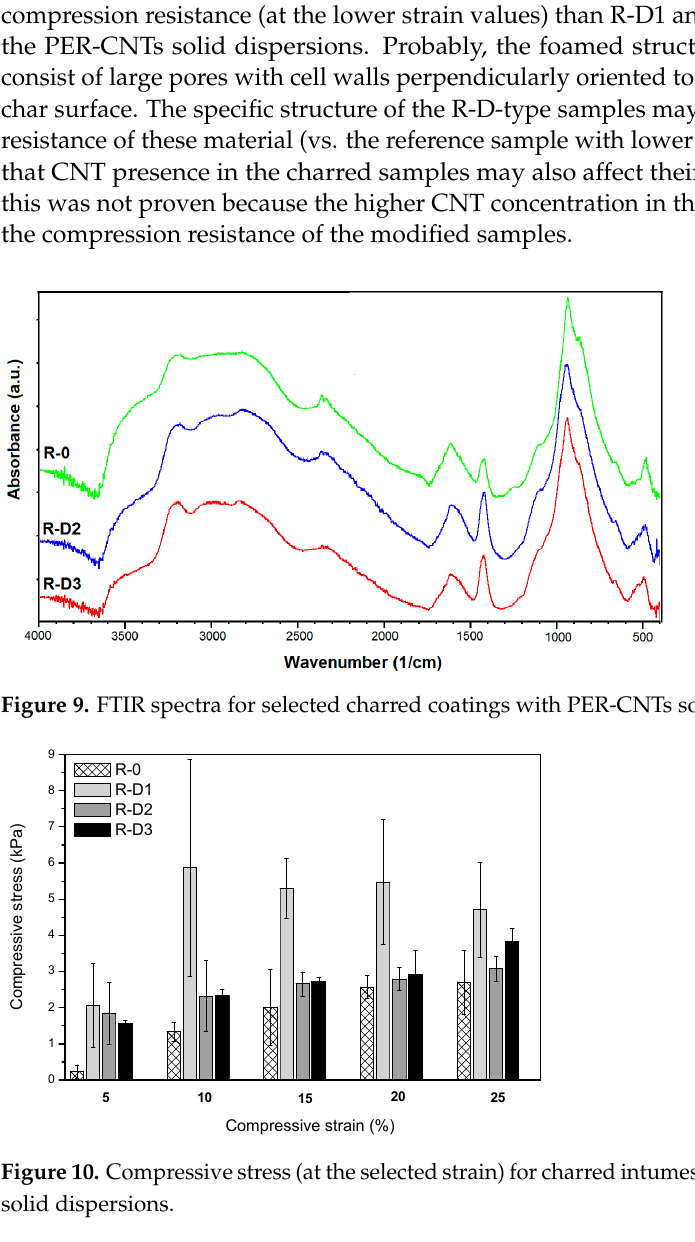
Figure 9. FTIR spectra for selected charred coatings with PER-CNTs solid dispersions.